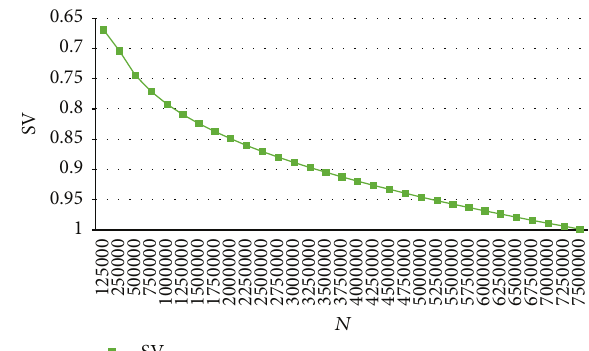
Figure 6: Life cycle of ACM in the pavement construction depend- ing on the number of loading cycles.